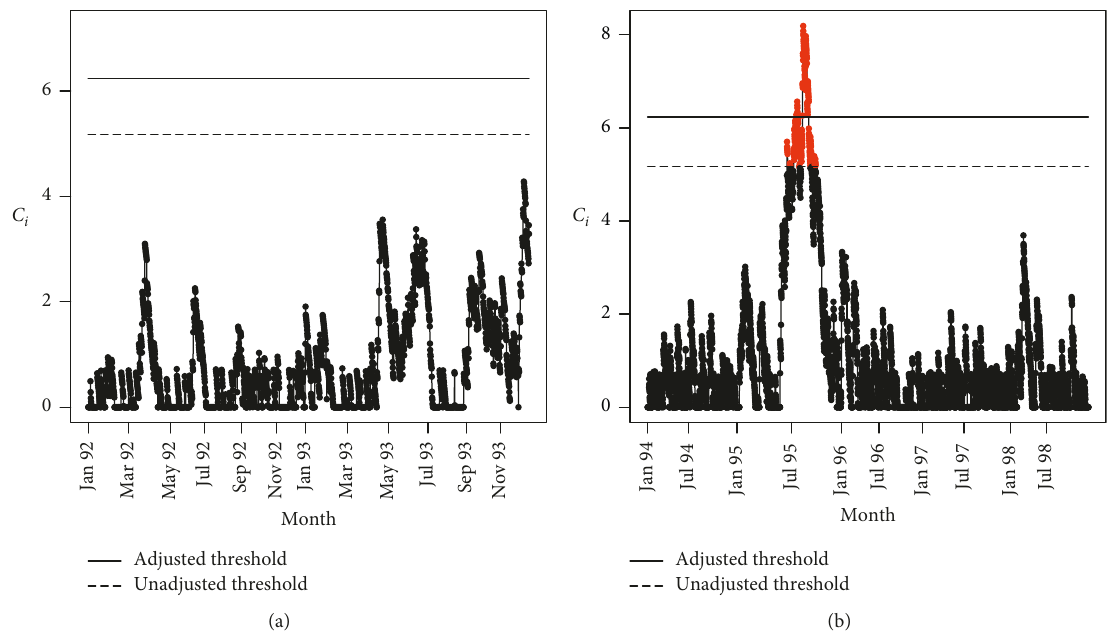
Figure 1: RA-CUSUM chart for Phase-I and Phase-II assuming first two years as the Phase-I for 30 days mortality of cardiac surgery patients. (a) Phase-I chart, unadjusted UCL � 5.172 and adjusted UCL � 6.225. (b) Phase-II chart, unadjusted UCL � 5.172 and adjusted UCL �